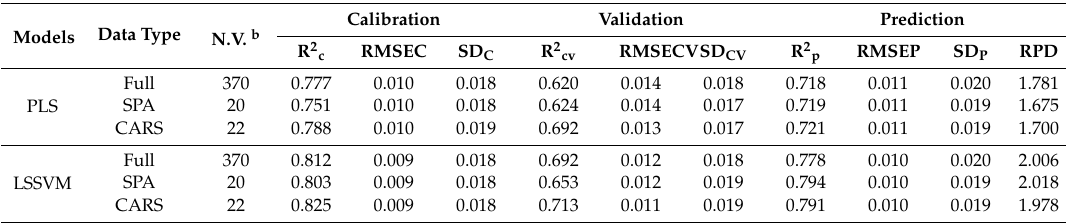
Table 3. Prediction results of water content by PLS and LS-SVM models using full spectra, wavelengths selected by SPA and CARS. Models Data